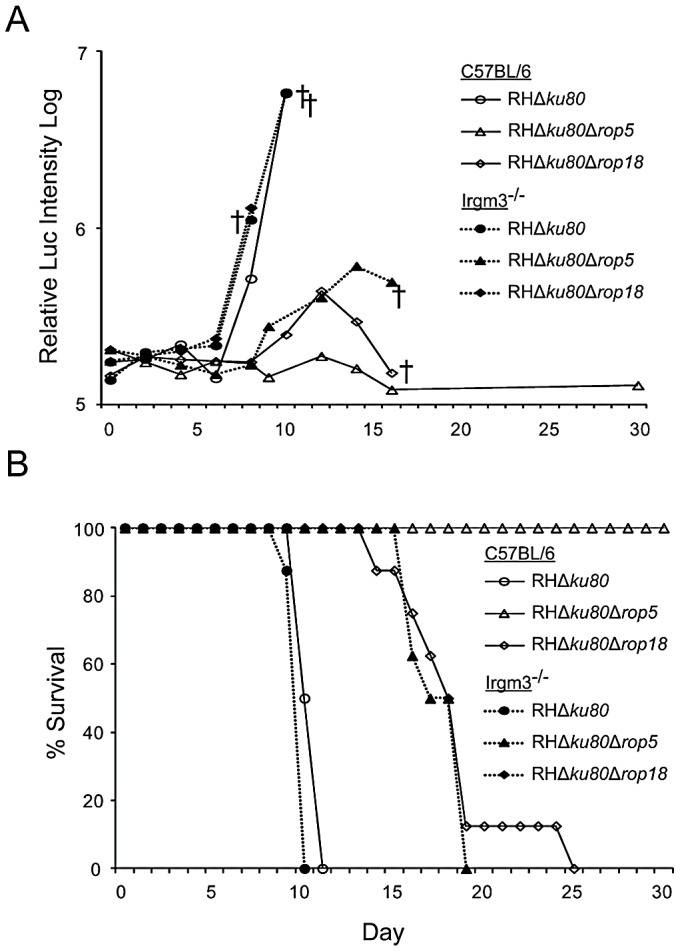
Irgm3 deficient mice revert the phenotypes of Δrop18 and Δrop5 parasites.(A) Wild type (C57BL/6) (n = 4 per parasite strain) or Irgm3 deficient (Irgm3−/−) (n = 4 per parasite strain) mice were infected with 102 luciferase expressing wild type (RHΔku80), ROP5 deficient (RHΔku80Δrop5), or ROP18 deficient (RHΔku80Δrop18) parasites by s.c. injection and imaged on indicated days. † denotes one or more death per group. Representative experiment. (B) Survival curves for mice challenged with T. gondii strains as shown. Combination of two experiments (n = 8 animals per group).